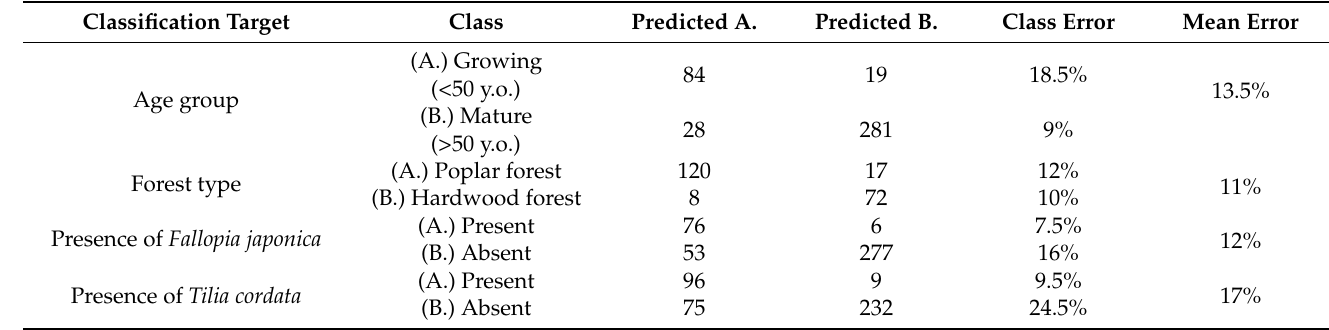
Table 8. Class error for each of the four random forest classifiers (HS + LiDAR) once the random forest classifier was used to predict classes for each of the forest plots, instead of only the training data. The total number of plots was lower for the Forest Type classification target, due to the definition of each class (>75% black poplar or European ash trees in the plot), not including all forest plots.